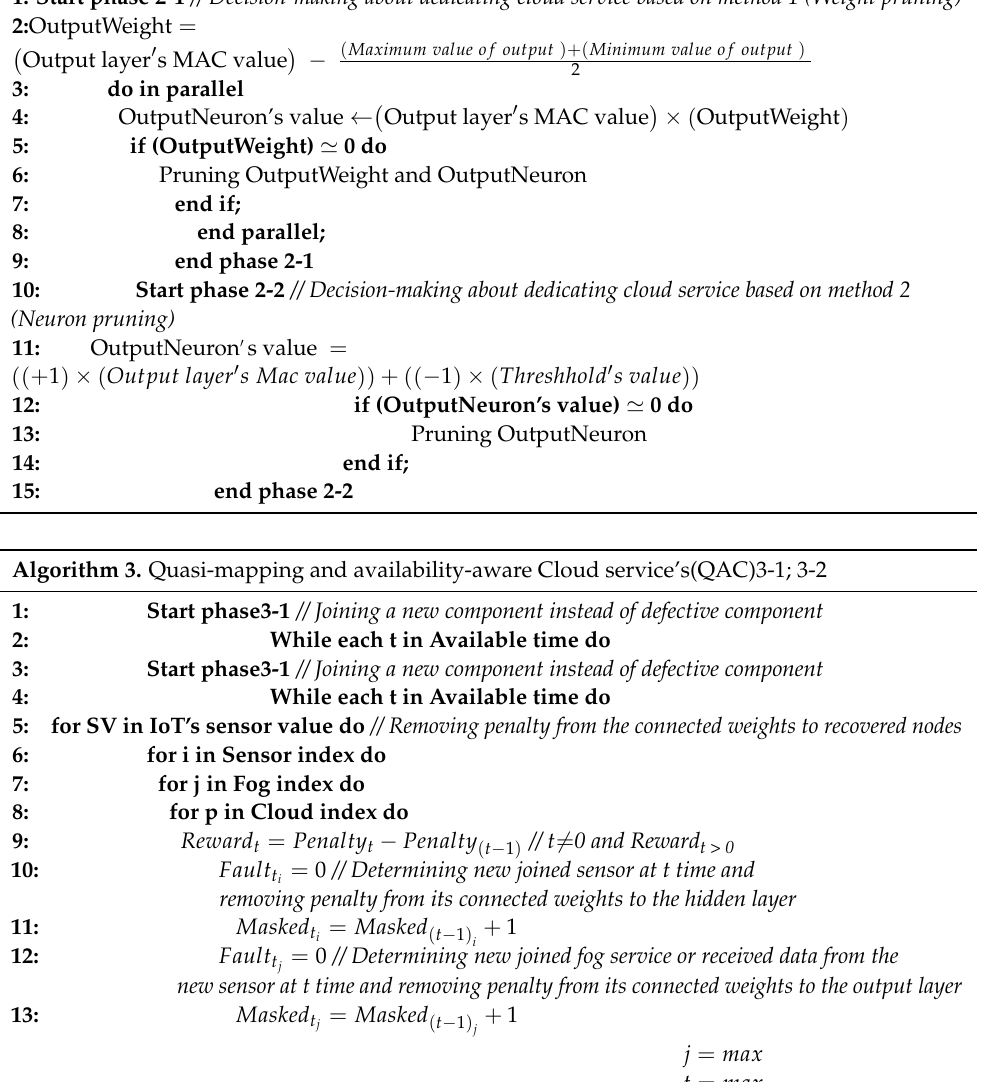
Algorithm 2. Quasi-mapping and availability-aware Cloud service’s(QAC)2-1; 2-2